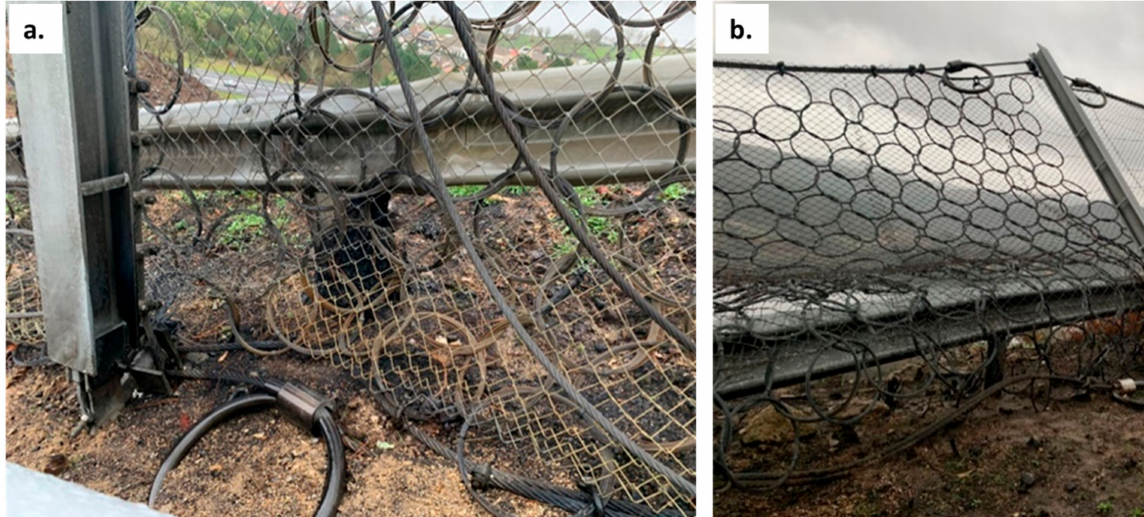
Figure 6. ( a ) Degradation of the cables and energy dissipators after a wildfire. ( b ) Dynamic barrier for protection against rockfalls affected by a